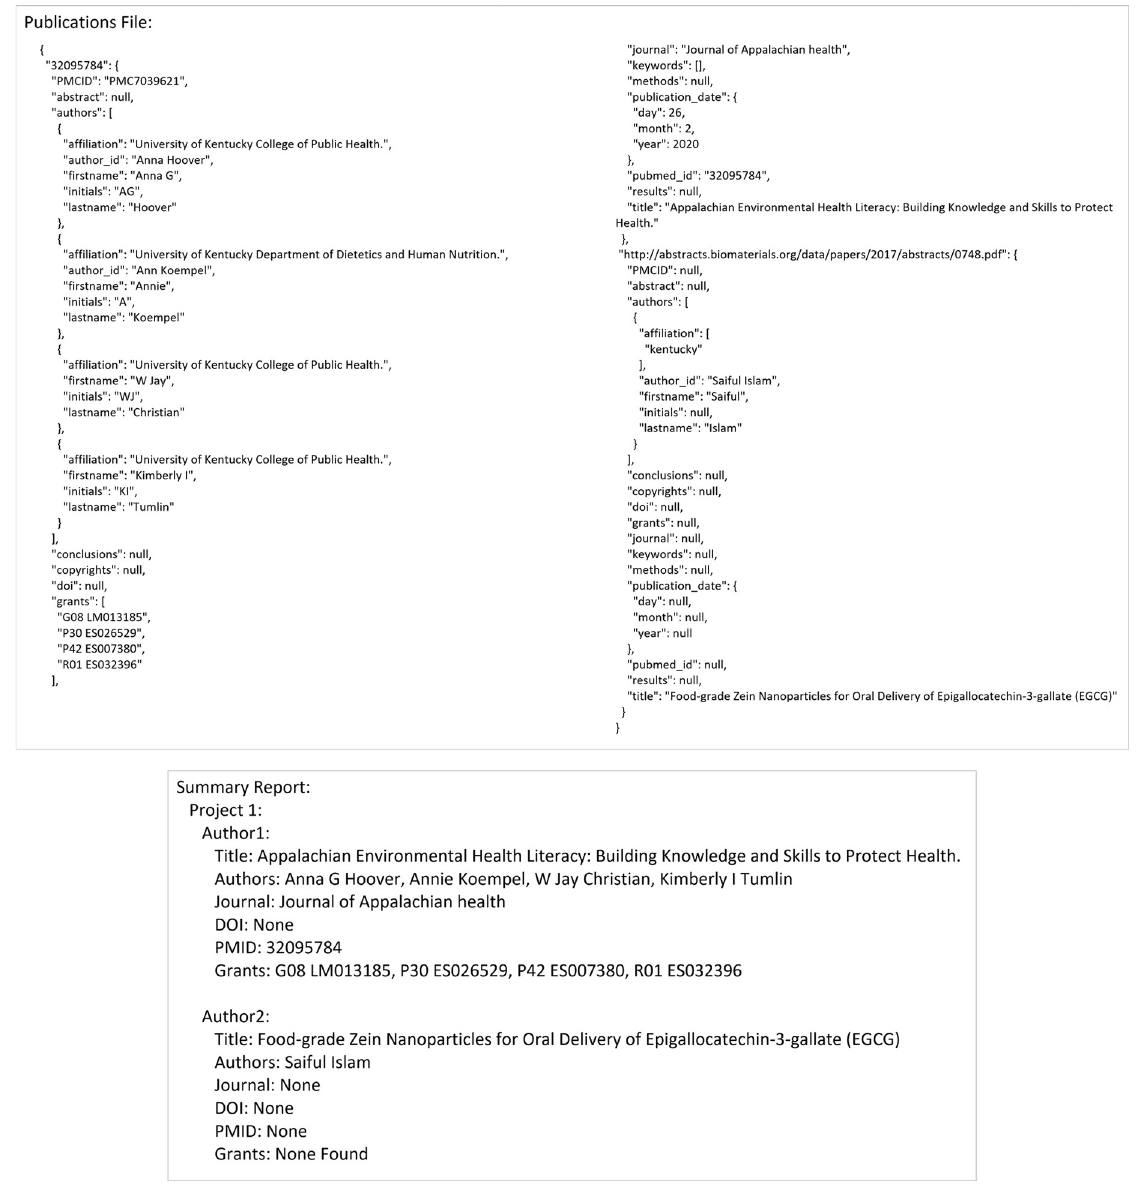
Fig 4. Output file contents for the author_search use-case. Example JSON publications output and plain-text summary report from the author_search for publications use-case